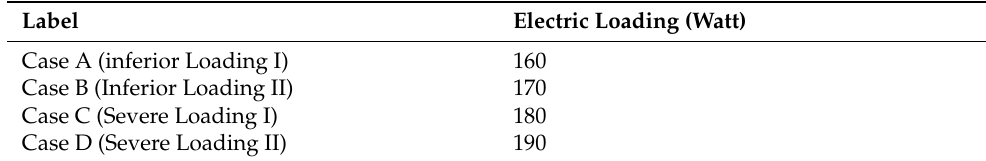
Table 2. Experimental Loading Conditions.